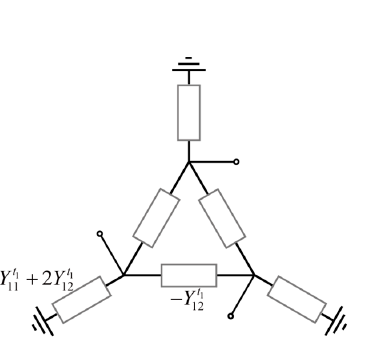
Figure 2. Equivalent circuit diagram of the symmetrical three-port network at reference plane t 1 .